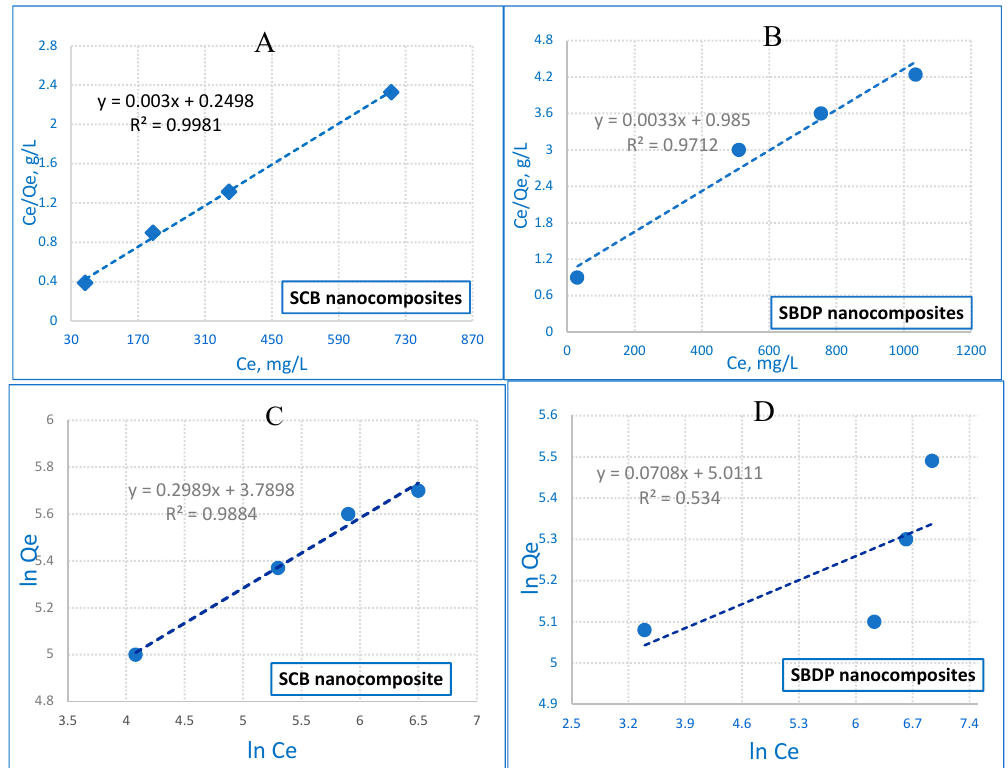
Figure 8. Langmuir adsorption for Ni ion removal on ( A ) SCB nanocomposites and ( B ) SBDP nanocomposites and Freundlich adsorption for Ni ion removal on ( C ) SCB nanocomposites and ( D )